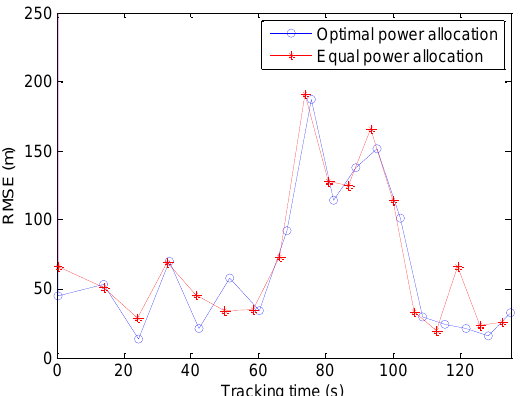
Figure 8. The root mean square error ( RMSE) of optimal and equal power allocation. RMSE is the root mean square error of the target.